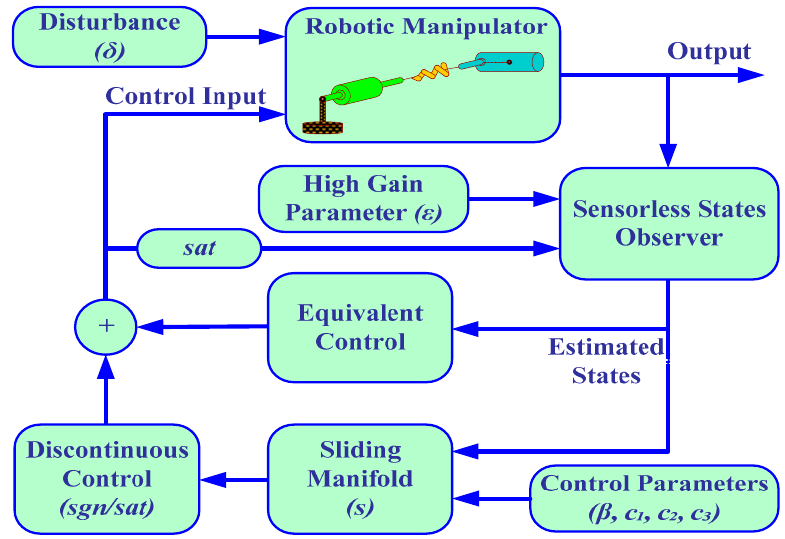
Figure 2. Block diagram of the SFJRM with proposed output feedback controller. Table 1. System parameters.